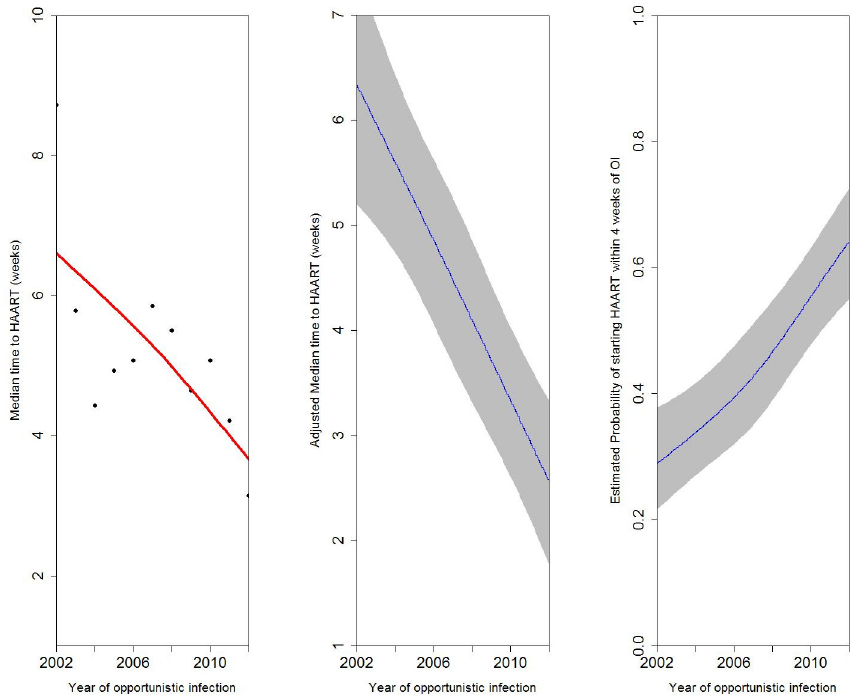
Fig 3. Trends over time in HAART initiation after an opportunistic infection (OI). A) Median time to HAART initiation over time (black dots are the median times according to calendar year, red line is the adjusted model. B) Trend across time adjusting for age, gender, route of HIV transmission, and CD4 count at enrolment, and tuberculosis diagnosis. C) Probability of starting HAART within 4 weeks of OI diagnosis over time adjusting for age, gender, route of HIV transmission, and CD4 count at enrolment, and tuberculosis